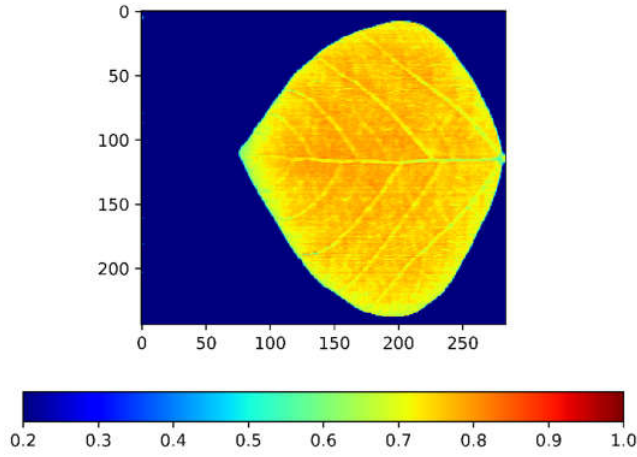
Figure 5. Whole-leaf NDVI heatmap captured by Leafspec-Dicot.